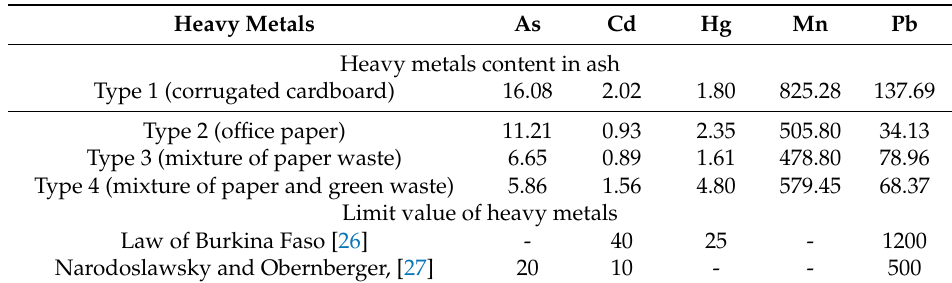
Table 4. The heavy metals content in the ash and the limit value in heavy metals for application of ash in soil (mg metal /kg ash ).